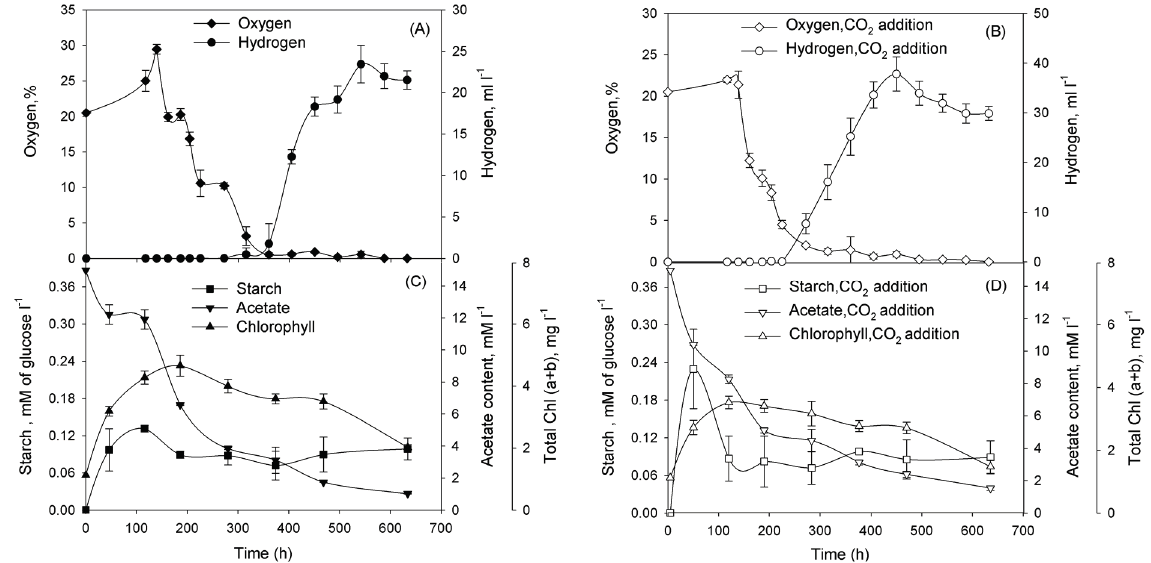
Figure 3. Incubation of Chlorella sp. in TA-P/NaCl medium without CO 2 ( A , C ), and with CO 2 additions ( B , D ). At the start of incubation the gas phase was supplemented with CO 2 to 10% ( v / v ). Parameters that were examined: ( A , B ) O 2 concentration in a gas phase of vials (%) and volume of the H 2 gas produced (mL·L − 1 of suspension); ( C , D ) intracellular starch and acetate in the medium (mM·L − 1 ), total (a + b) chlorophyll (mg·L − 1 ). Figure represents data of typical experiments from three independent repetitions with the same trend. For all graphs on Figure 3 simple error bars curves were used.